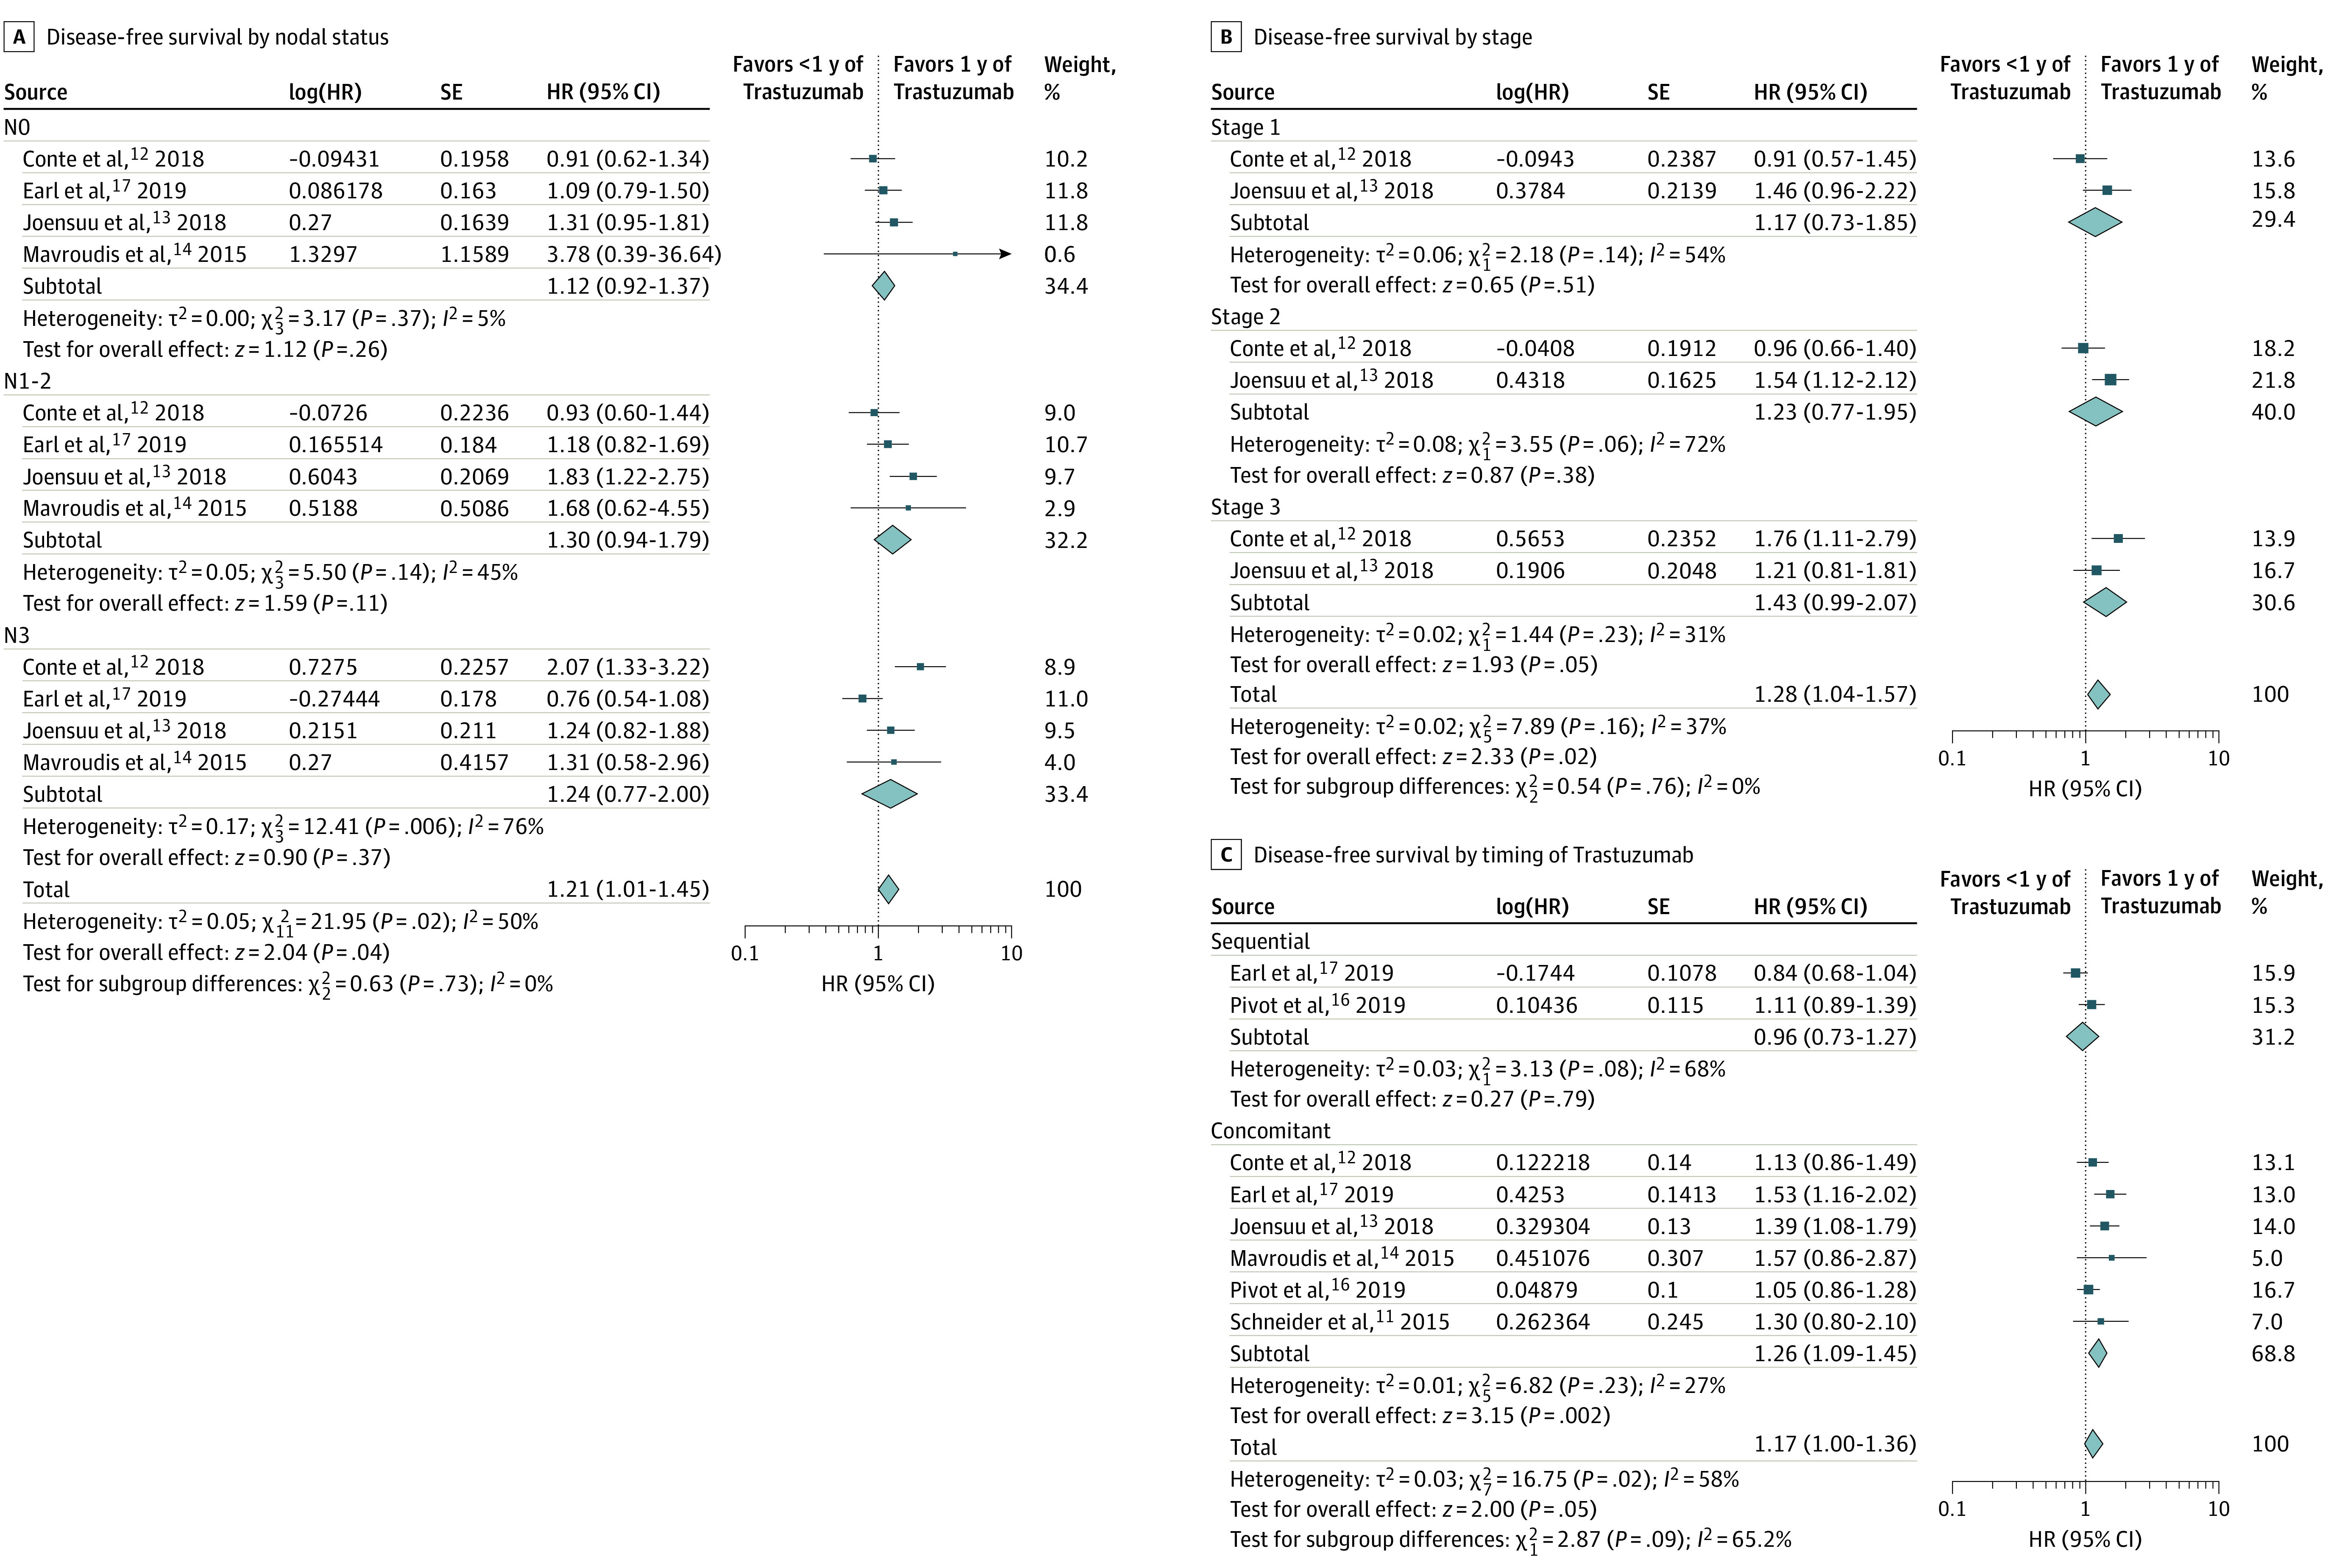
Hazard Ratio (HR) Plots for Disease-Free Survival by Nodal Status, Stage, and Timing of Trastuzumab AdministrationThe number of events in subgroups are based on data in eTable 7 in the Supplement.